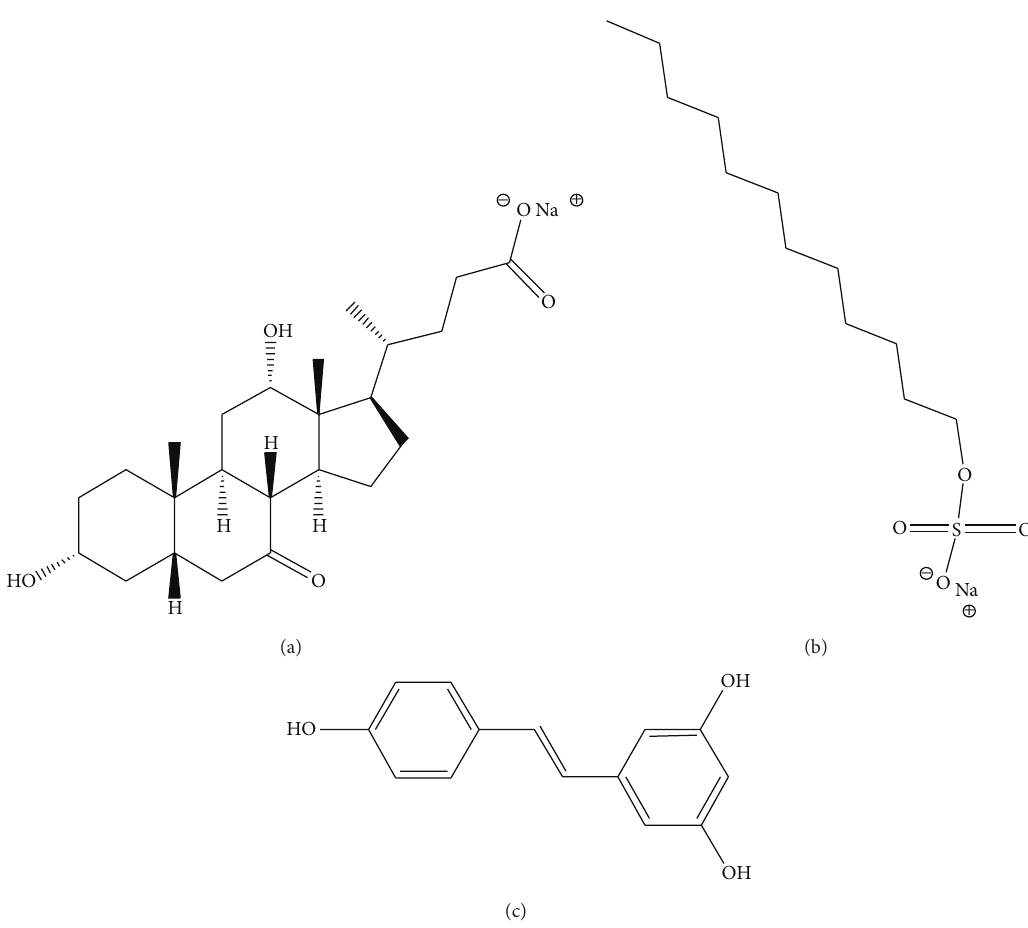
Figure 1: Analyzed surface-active substances (a) sodium 3 𝛼 ,12 𝛼 -dihydroxy-7-oxo-5 𝛽 -cholanoate (sodium-7-oxo-deoxycholate, S7-OD), (b) sodium dodecyl sulphate (SDS), and (c) resveratrol ( trans -3,5,4 󸀠